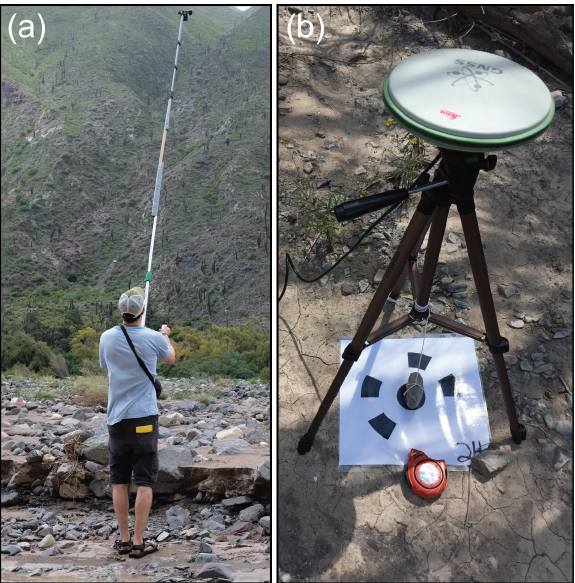
Figure 7. Sony α 6000 24-megapixel camera affixed to mast for photo collection at a height of 4.5–5m (a) and differential GPS measurement of coded targets (b)